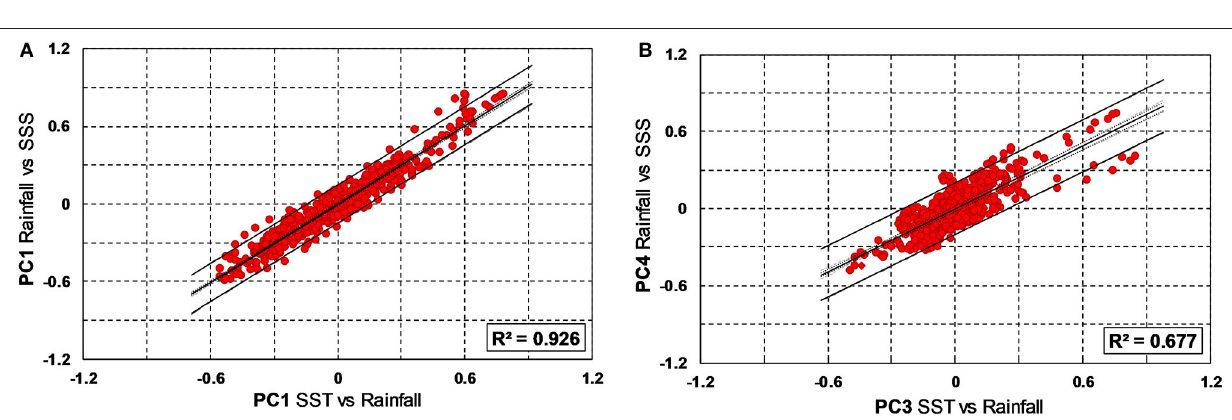
Frontiers in Marine Science |